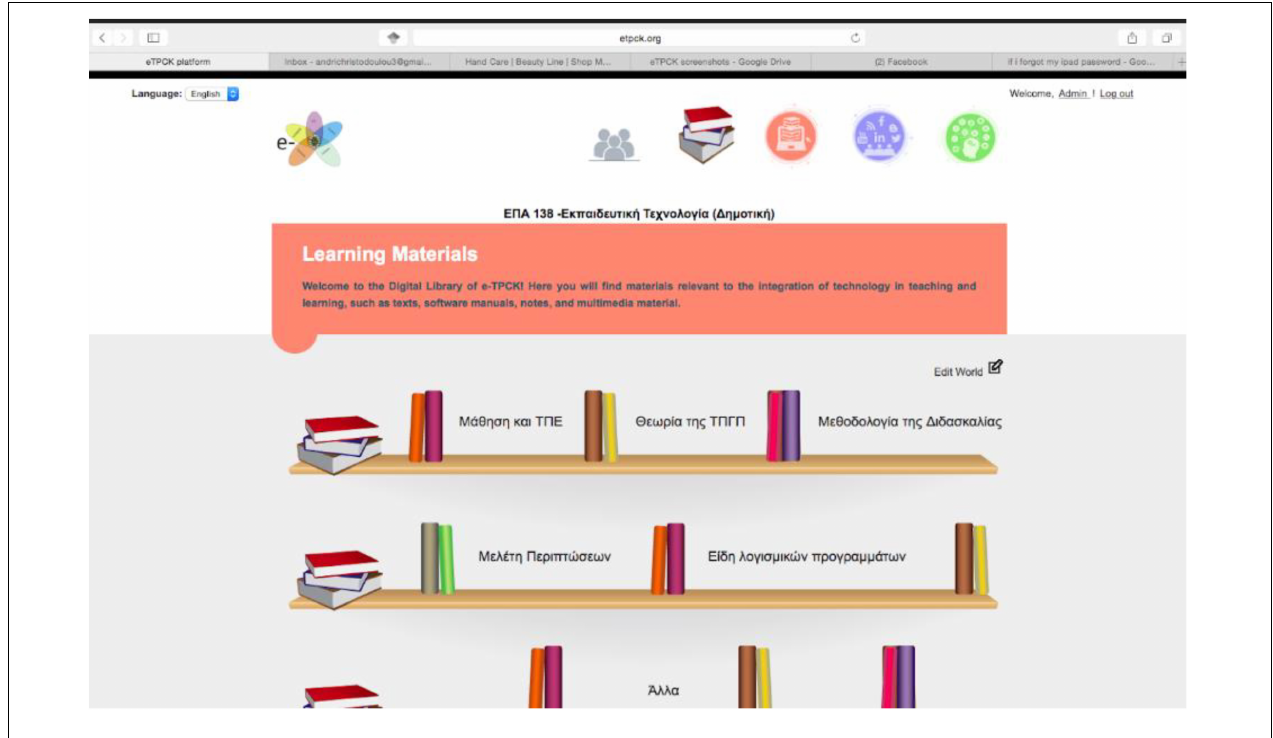
FIGURE 1 | Learning materials space.